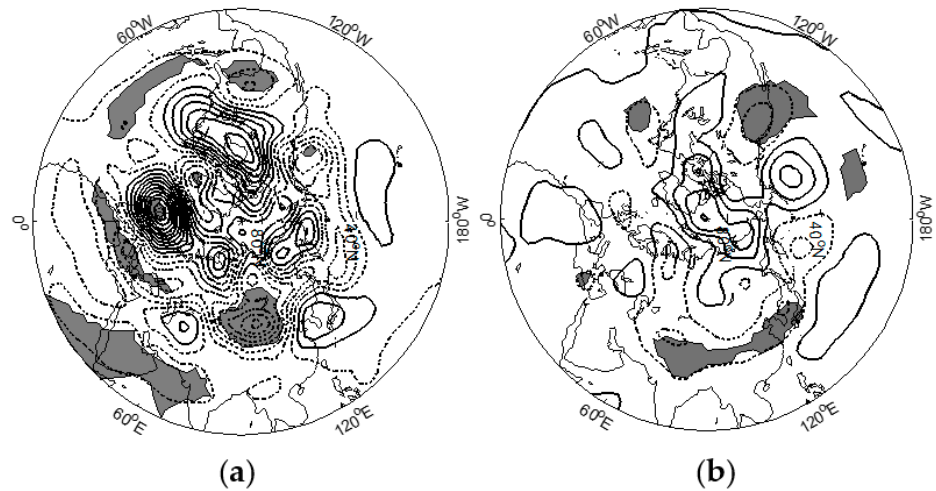
Figure 15. Composites of the July and August mean 500 hPa height anomaly for the extreme precipitation years ( a ) and normal precipitation years ( b ). The shading denotes the 90% confidence level, the dashed/solid lines indicate negative/positive values, and the contour interval is 4 gpm.